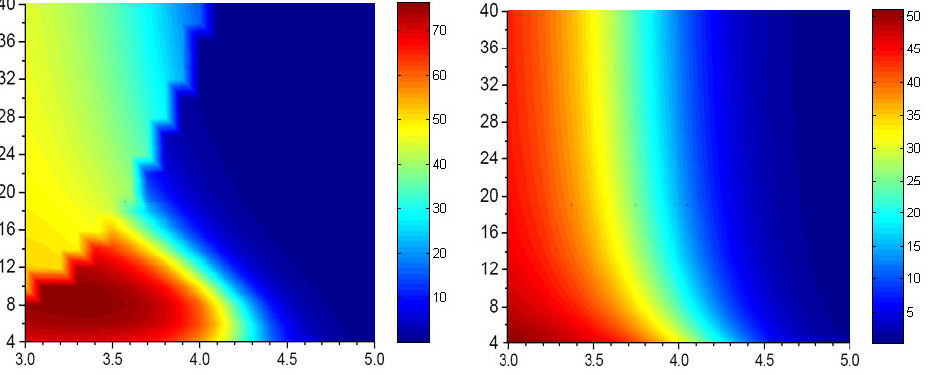
Figure 5. Chain size dependence of the three low-lying excited states of polyene dimers with interchain distance of 3.8 Å (calculated by model